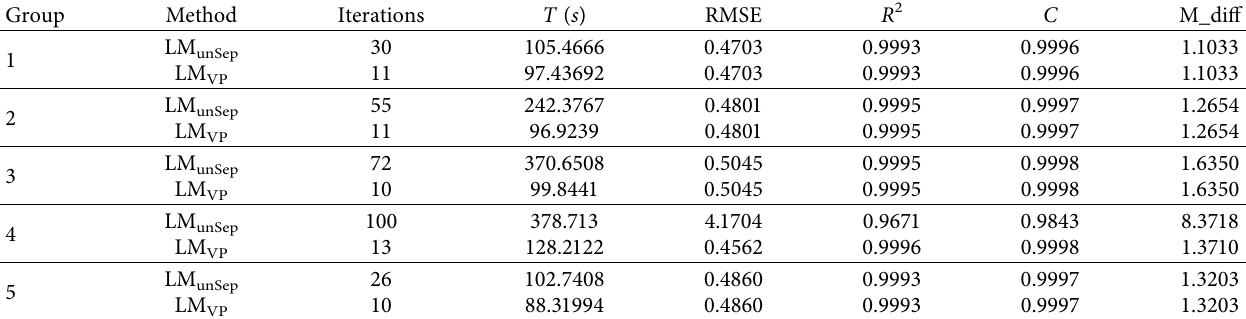
Table 3: Comparison of the evaluation coefficients obtained from analysis of the results of the two methods used to simulate the data from the five different groups. Group